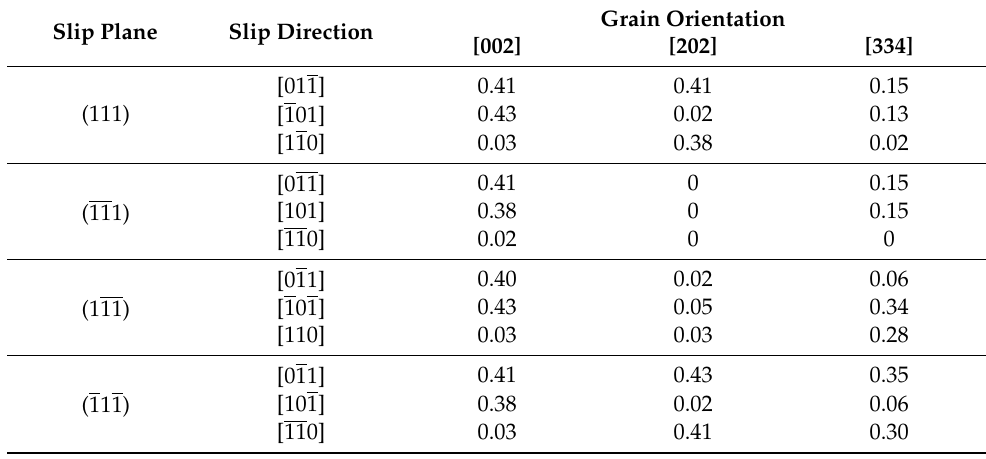
Table 3. Schmid factors of the investigated grains for different slip systems calculated from Euler angles measured with EBSD with applied load in the z direction (parallel to the grain orientation).